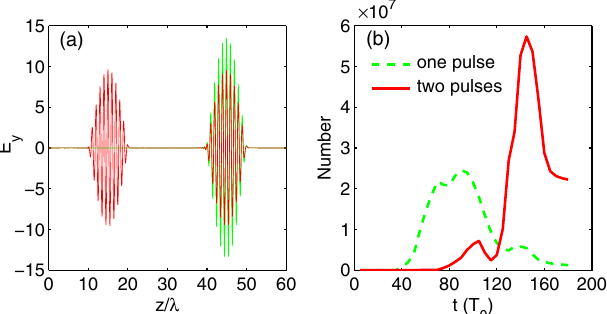
FIG. 7. (a) Profiles of the single and two pulse lasers. The intensity of the single laser pulse is double that of the two pulses, while the duration is the same. (b) Evolution of the number of the high-energy (with kinetic energy > 100 MeV) electrons for the two cases. The number here is converted from the macroparticle number obtained from the 2D simulation. The laser duration τ ¼ 5 T b ¼ 10 λ , and the plasma density n 0 , spot radius The laser strength parameter is a L ¼ 10 for the two pulses case, ffiffiffi p 2 while a L ¼ 10 for the one pulse